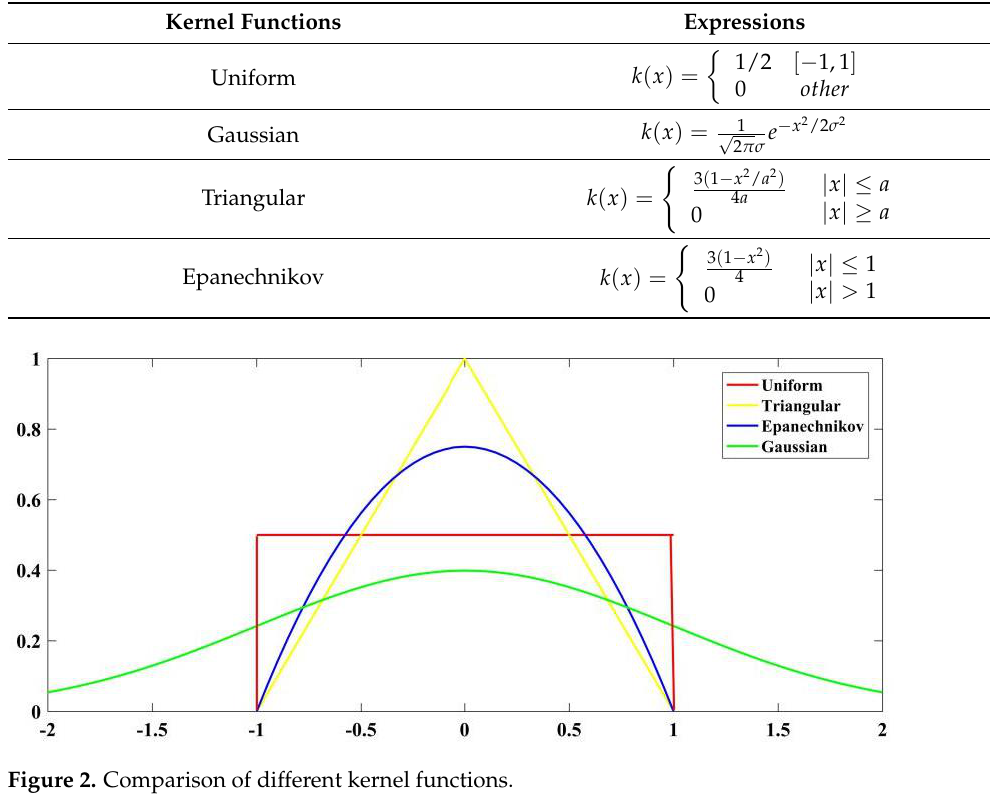
Figure 2. Comparison of different kernel functions.